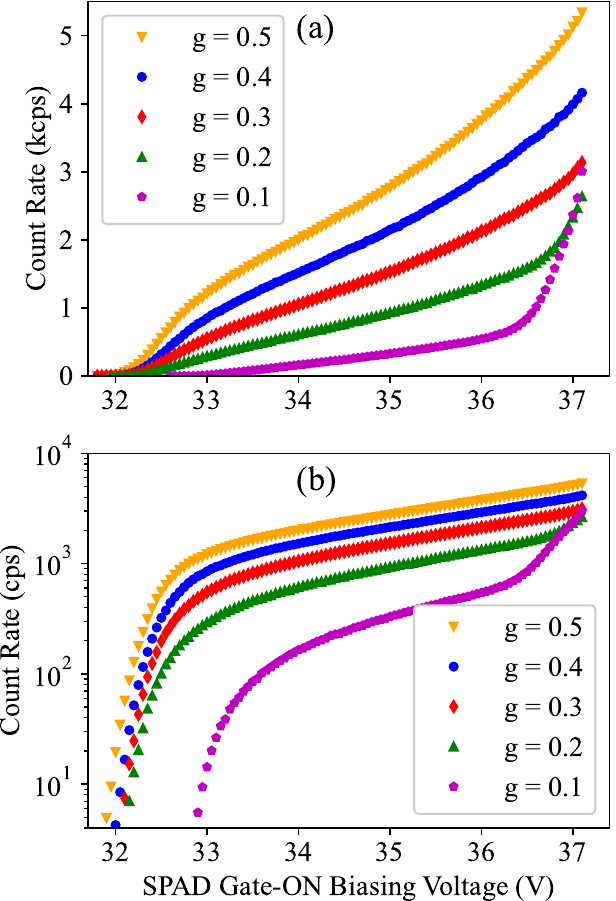
Figure 2. Measured detector count rate (in count per second) as a function of the SPAD gate-ON biasing voltage ( | V sub | + 3.3 V) and at different duty cycle ( g ) values plotted in linear ( a ) and logarithmic ( b ) scale. The values g = { 0.1,0.2,0.3,0.4,0.5 } correspond to the gating-durations of T G = {5 ns, 10 ns, 15 ns, 20 ns, 25 ns} as the gating pulse rate is 20